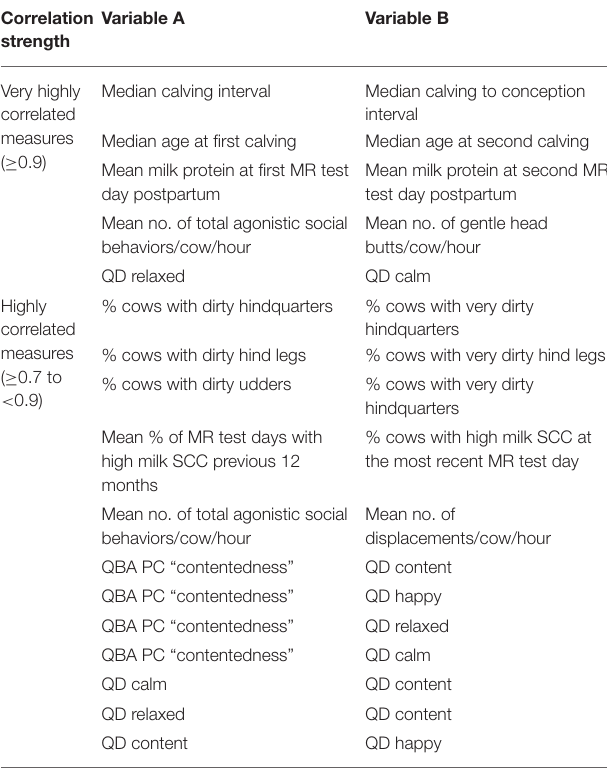
TABLE 2 | Very high and high pairwise correlations detected between the 95 continuous welfare outcome